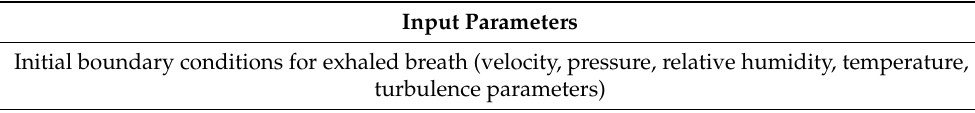
Table 4. Input parameters for CFD